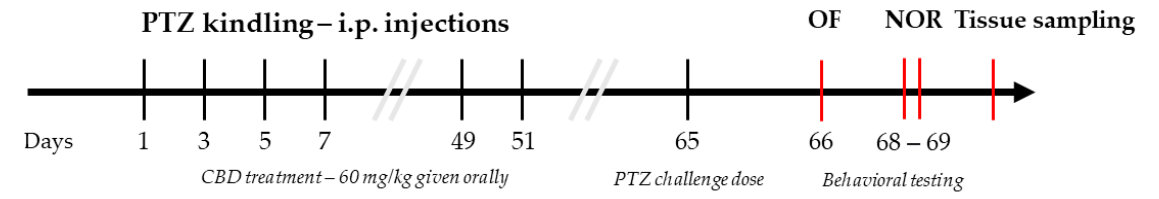
Figure 1. Timeline illustration of the experimental model. Cannabidiol was administered orally in a dose of 60 mg/kg each day, starting from day 0 until achieving a kindled state. Abbreviations: OF, open field test; NOR, novel object recognition test.